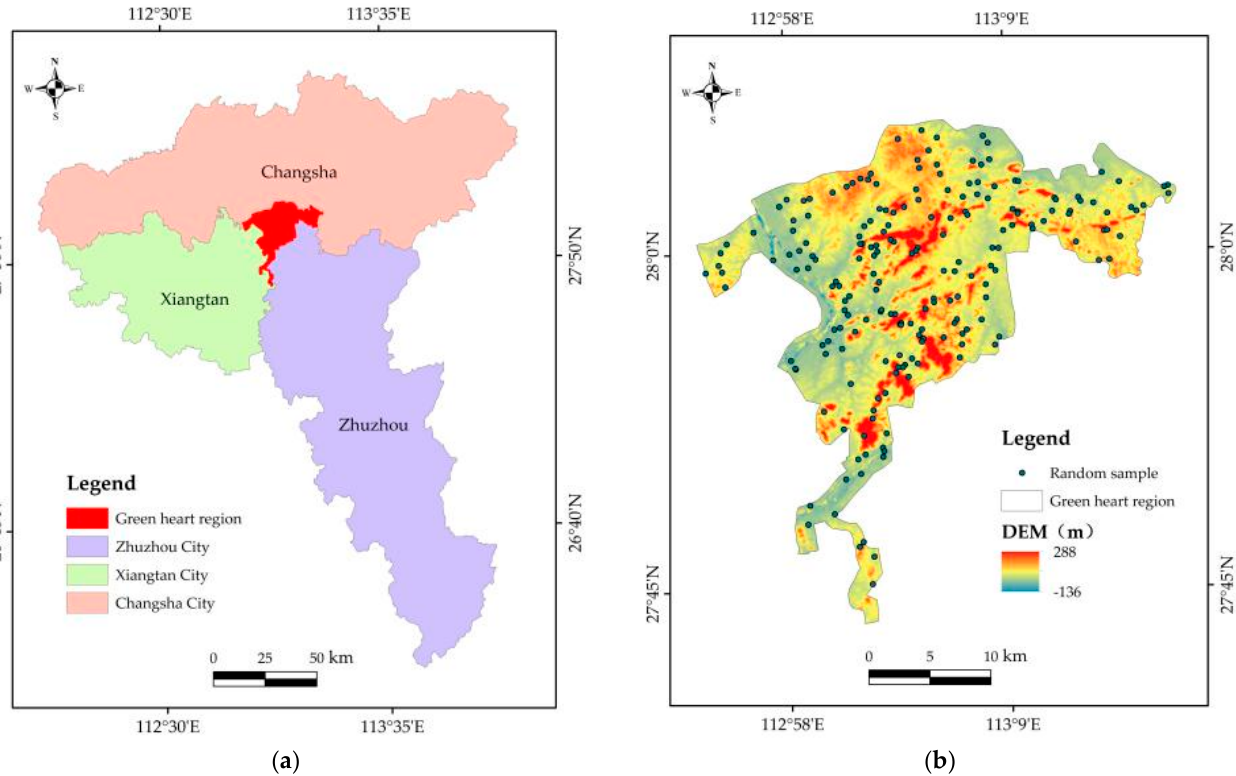
Figure 1. ( a ) Location of Green Heart in the Chang-Zhu-Tan Urban Agglomeration; ( b ) Elevation diagram of green heart.